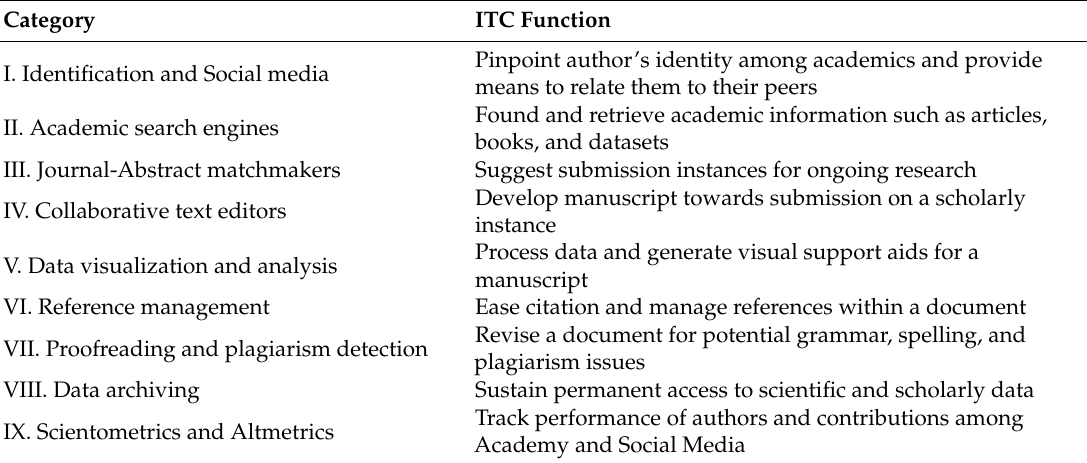
Table 1. Assisting software for the peer-review process taxonomy and function.